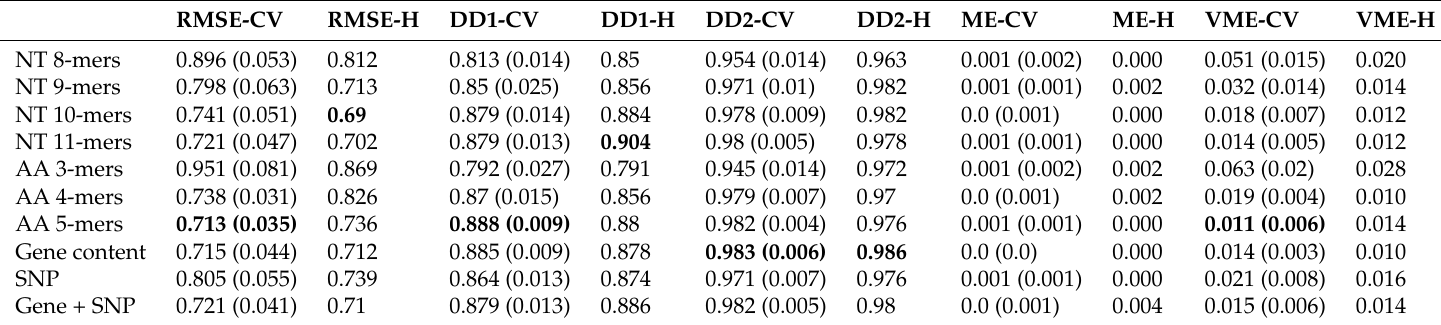
Table A62. S. enterica